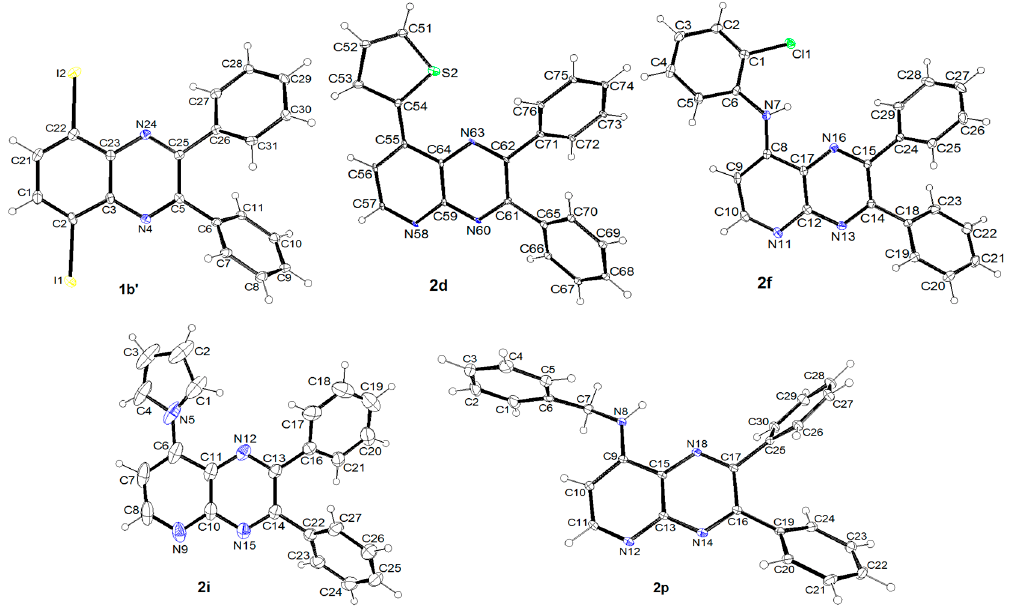
Figure 1. ORTEP diagrams (30% probability) of 1b’ , 2d , 2f , 2i , 2p .